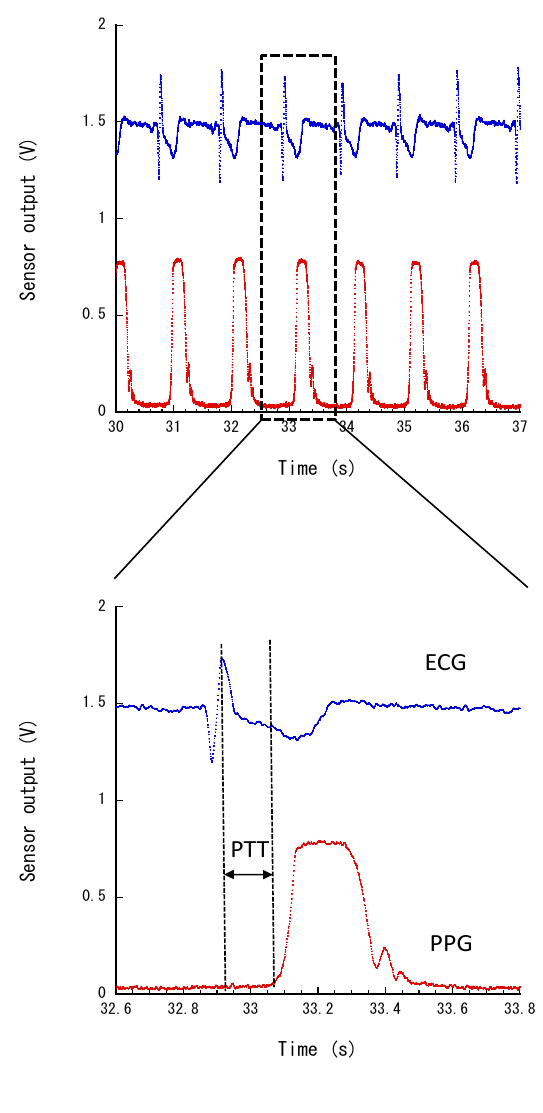
Figure 6. PTT estimated from ECG and